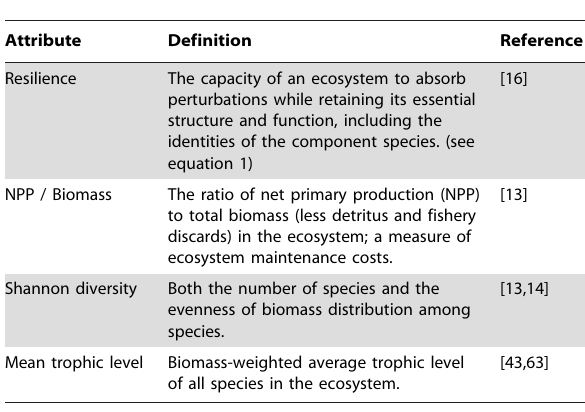
Table 1. Ecosystem attributes measured in simulations of increasing fishing and nearshore habitat pressure in the Northern British Columbia Ecopath with Ecosim marine food web